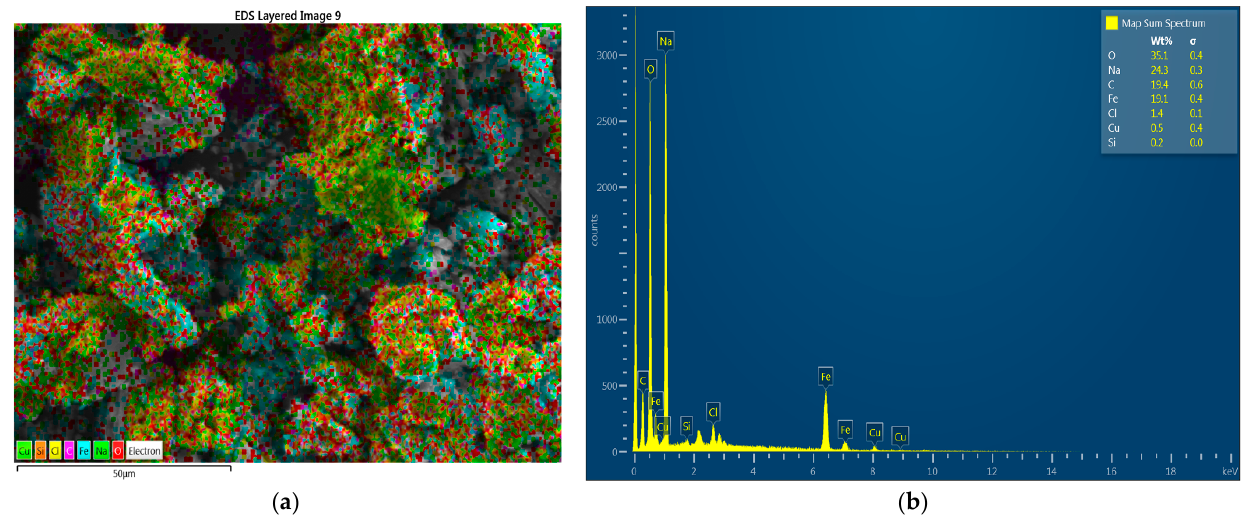
Figure 5. EDS image of bare Fe 3 O 4 NPs: ( a ) EDS colorization layer of identified elements in SEM micrograph of bare Fe 3 O 4 NPs, ( b ) EDS spectrum of bare Fe 3 O 4 NPs containing O, Na, C, Fe, Cl, Cu, and Si.